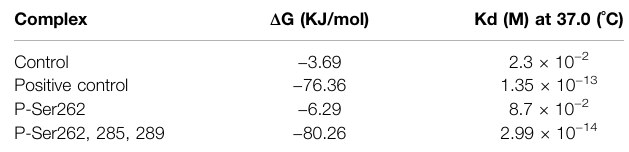
TABLE 1 | Binding energy ( Δ G) and dissociation constant (Kd) values for the control (non-phosphorylated tau), positive control ( Δ 280-tau), and the complexes with one (P-Ser262) and three (P-Ser262, 285, and 289) phosphorylation sites during 200 ns